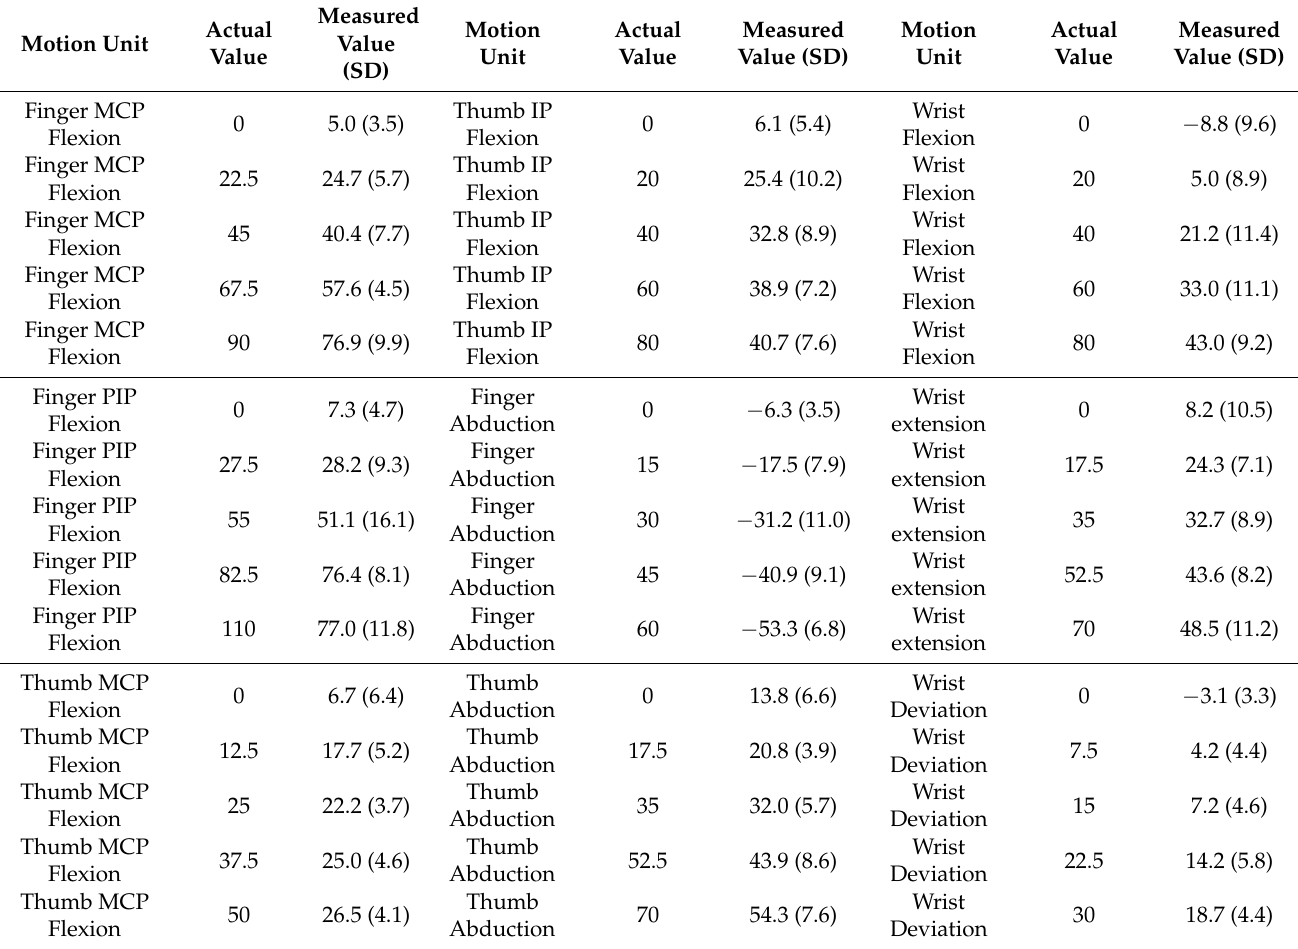
Table 3. Requirement angles configuration of motion primitive units for Experiment